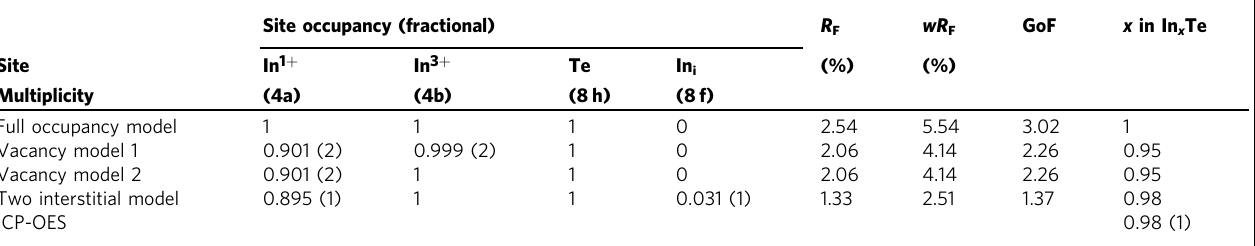
Table 1 Comparison of different structure models for InTe with intermediate steps to the two interstitial model at 25 K. Site occupancy (fractional) Site In 1